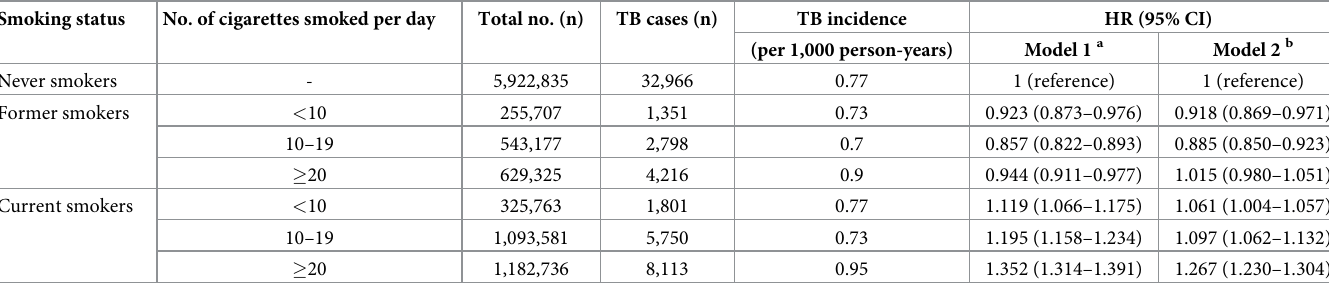
Table 3. Incidence and risk of tuberculosis according to daily smoking amount.